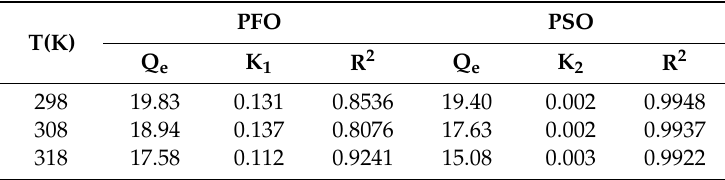
Figure 13. Adsorption kinetic for As(V) adsorption by CS-modified Dt (sorbent dosage: 0.4 g / L; initial As(V) ions concentration: 5 mg / L; pH 5). Table 3. Fitting parameters of kinetic equation.